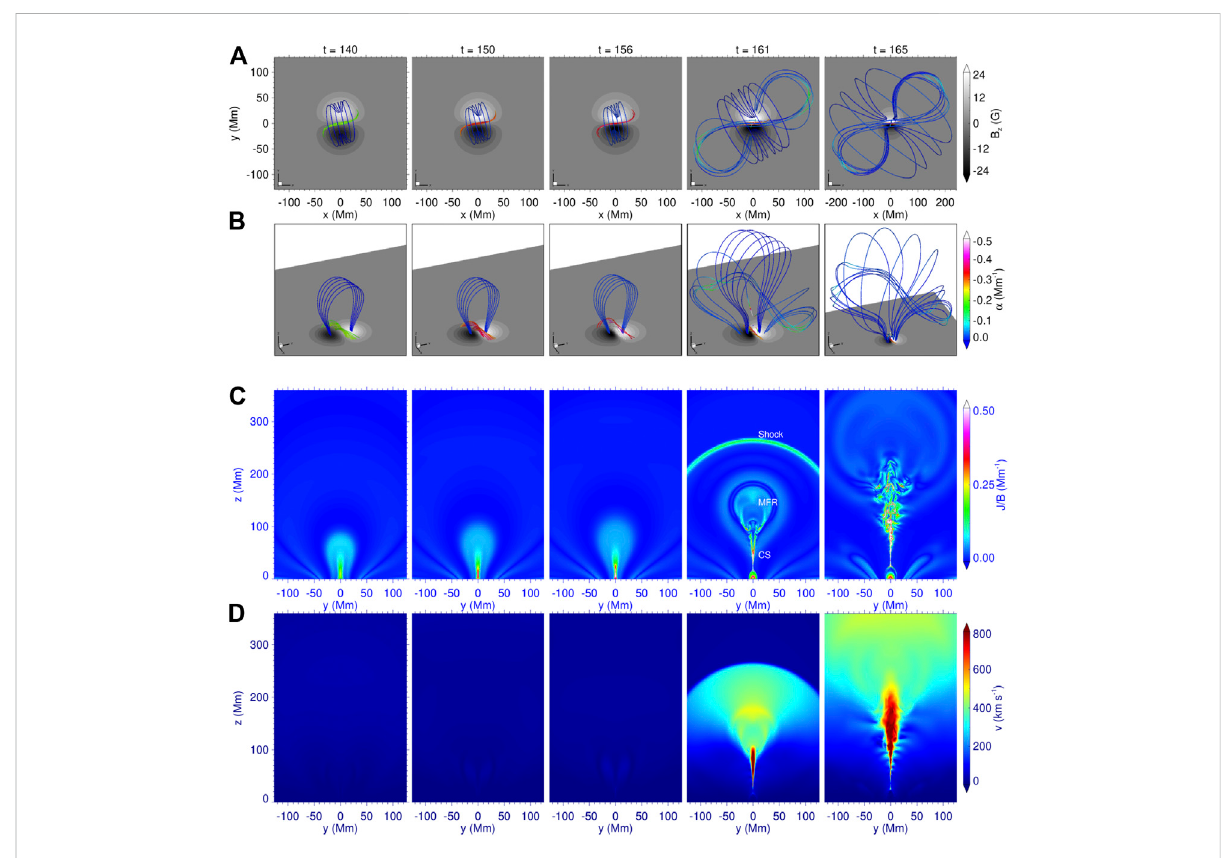
FIGURE 2 Evolution of magnetic fi eld lines, electric current, and velocity during the simulation process. (A) Top view of magnetic fi eld lines. The colored thick linesrepresent themagnetic fi eld line,and thecolors denote thevalueofthe nonlinear force-free factor de fi ned as α = J · B / B 2 , which indicates how much the fi eld lines are non-potential. The background is plotted for the vertical magnetic component B z on the bottom surface. (B) 3D perspective view of the same fi eld lines is shown in the panel (A) . Panel with t = 165 has a larger range. (C) Distribution of current density, J , normalized by magnetic fi eld strength, B , on the vertical cross section, that is, the x = 0 slice. (D) Vertical cross section of the velocity. The maximum velocity and Alfv (cid:1) enic Mach number are also denoted. This fi gure is available as an